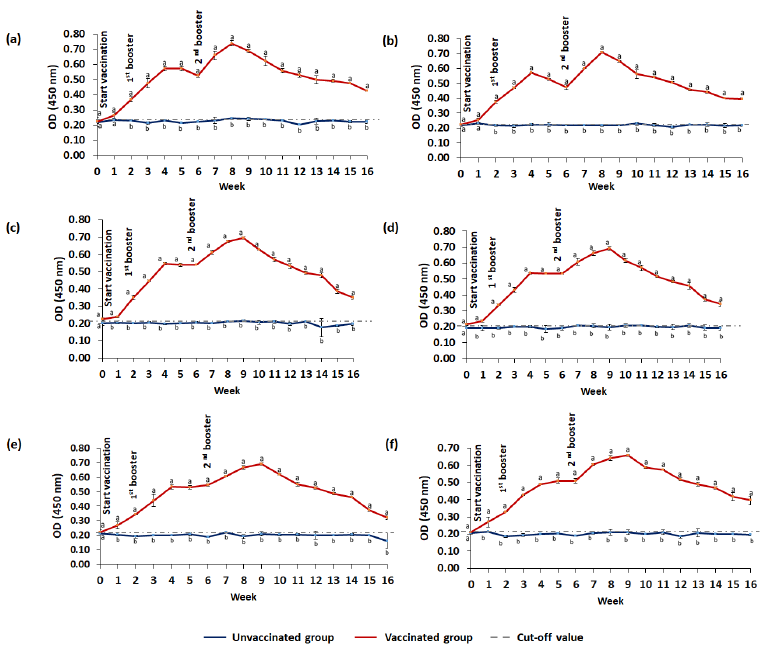
Figure 8. Specific IgM levels against S. agalactiae and A. hydrophila in red hybrid tilapia. The blue line represents the unvaccinated (control) group, and the red line represents the vaccinated group. Serum IgM levels against S. agalactiae ( a ) and against A. hydrophila ( b ). IgM levels against S. agalactiae in gut lavage ( c ) and against A. hydrophila ( d ). IgM levels in skin mucus against S. agalactiae in skin mucus ( e ) and against A. hydrophila ( f ). The number of fish used per time point ( n = 6). Values are mean ± standard deviation in triplicate samples. One-way ANOVA was performed with the Tukey–Kramer post hoc test to compare IgM levels between vaccinated and unvaccinated groups. Means with different superscripts (a–b) differ significantly at p ≤ 0.05 (one-way ANOVA) significance level.